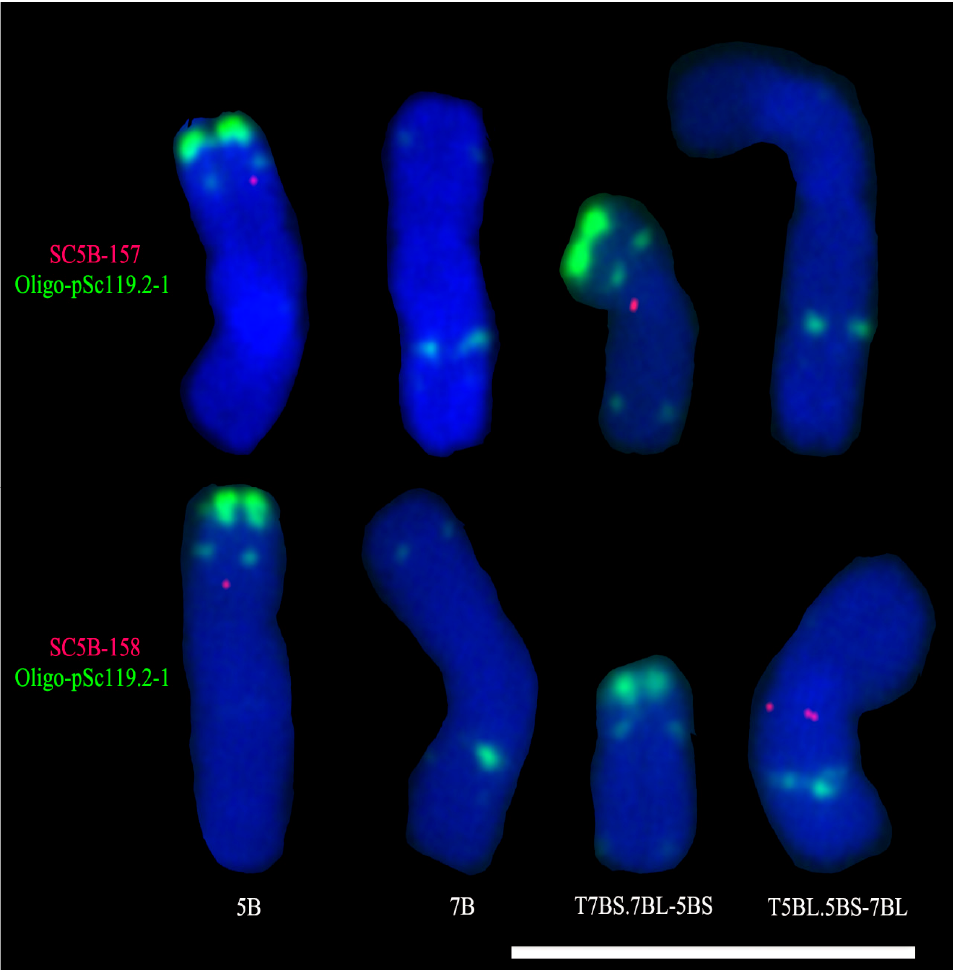
Figure 2. FISH analysis of chromosomes 5B and 7B of Chinese Spring and the translocations T5BL.5BS-7BL/T7BS.7BL-5BS of Chuanmai 62 using single-copy probes SC5B-157 (red) and 7BL/T7BS.7BL-5BS of Chuanmai 62 using single-copy probes SC5B-157 (red) and SC5B-158 (red), and SC5B-158 (red), and oligo probe Oligo-pSc119.2-1 (green). Cut-and-paste chromosomes are oligo probe Oligo-pSc119.2-1 (green). Cut-and-paste chromosomes are displayed. Scale bar: 100 µ displayed. Scale bar: 100 μ m.